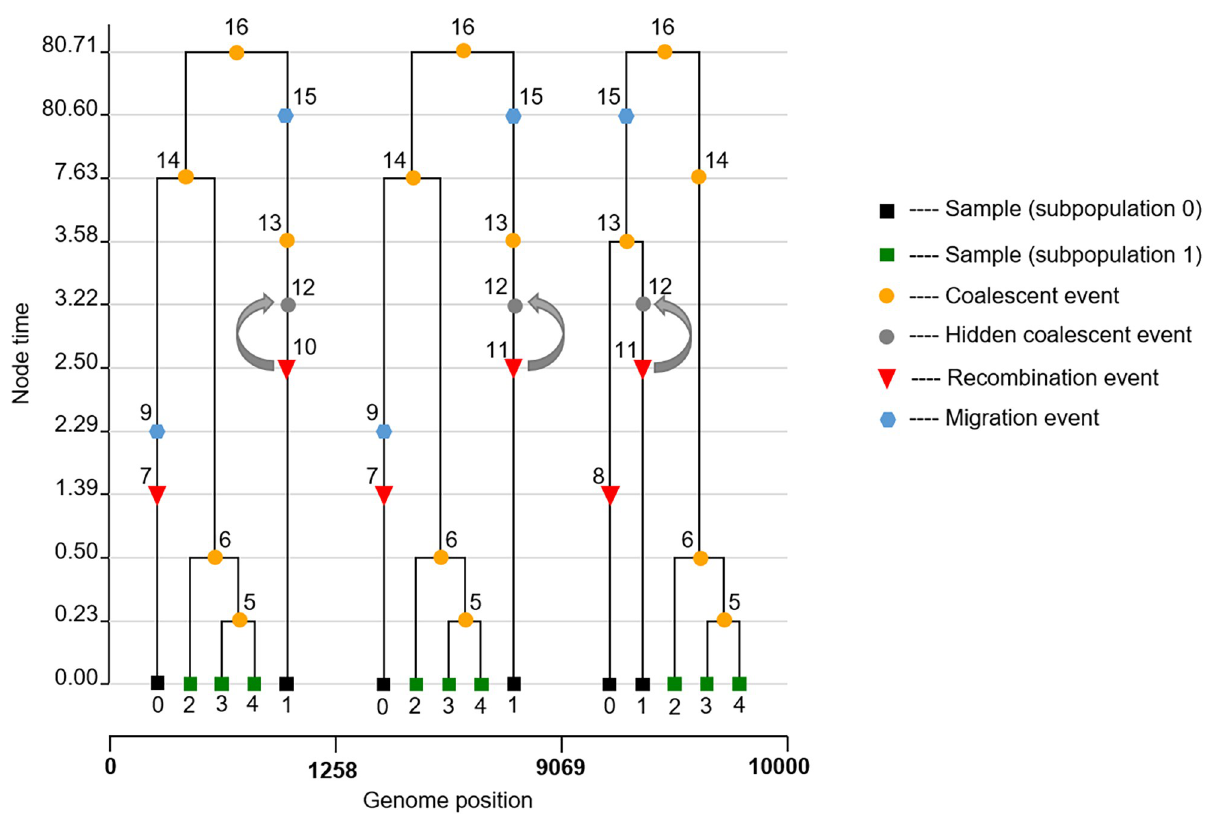
Fig 1. An ancestral recombination graph. In this example, an ARG was simulated for five individuals sampled in two subpopulations (0 and 1) using msprime [26]. Two recombination events happen, dividing the genome into three segments each with their own local tree. The first and second local tree have the same topology, because after the recombination event (indicated by nodes 10 and 11) the two parent lineages coalesce with one another (indicated by the grey arrow) at a hidden coalescent event (indicated by node 12), which would not normally be observed in the local trees. The second and the third local tree are topologically discordant due to a recombination event (indicated by nodes 7 and 8).